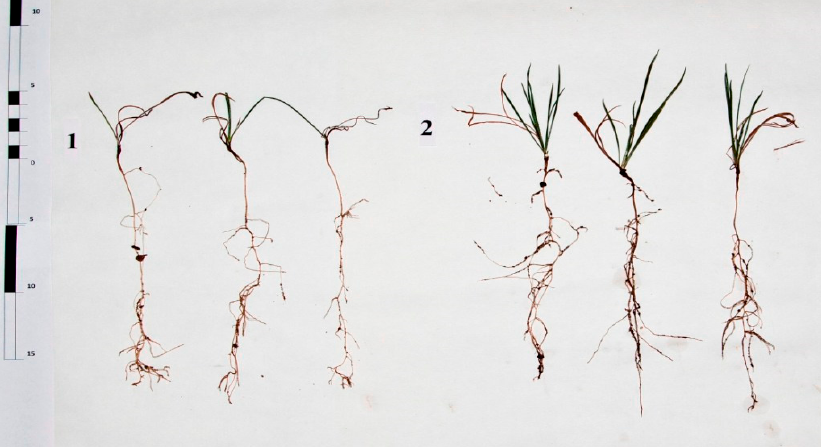
Figure 8. Vermicompost influence on the S. tau-saghyz dry weight.